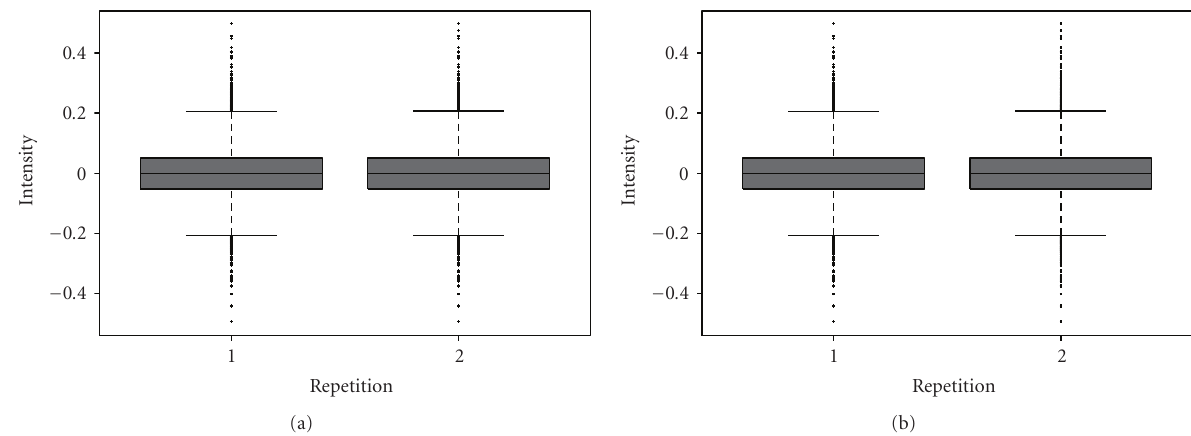
Figure 9: Repetition: the box plot showing the distribution of log T/C values for each repetition of the BAC clones (a) before correction and (b) after correction. In the RPCI microarray facility, each BAC clone is spotted twice on the